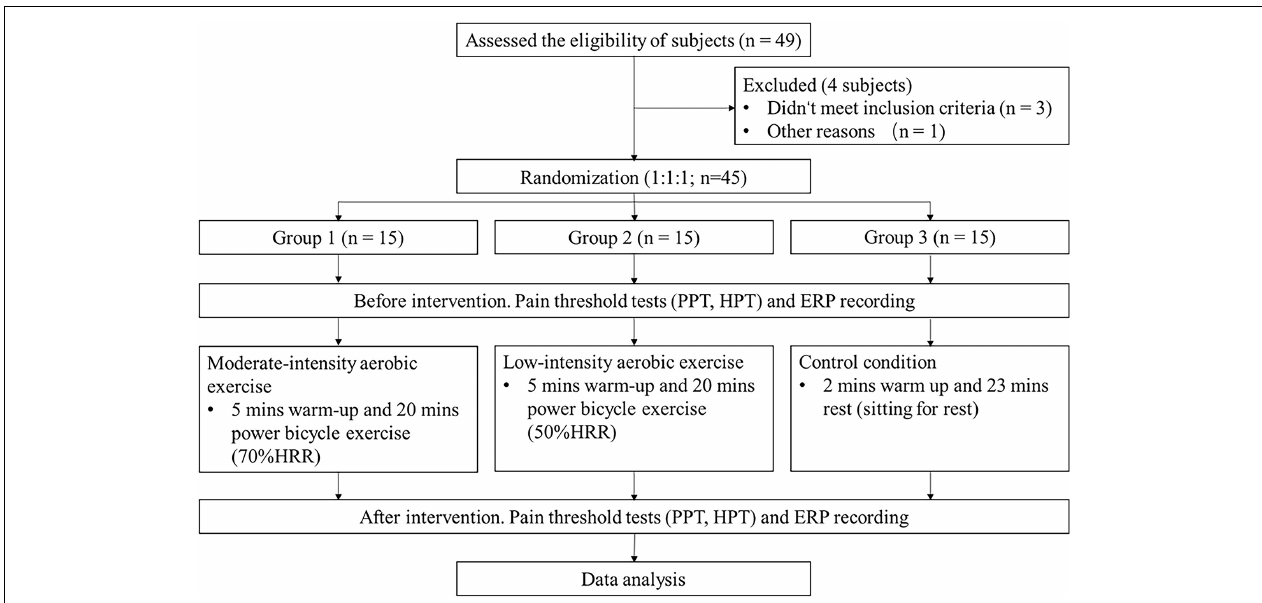
FIGURE 1 | Experimental flow chart. PPT, pressure pain threshold; HPT, heat pain threshold; CHEPs, contact heat-evoked potentials; HRR, heart rate